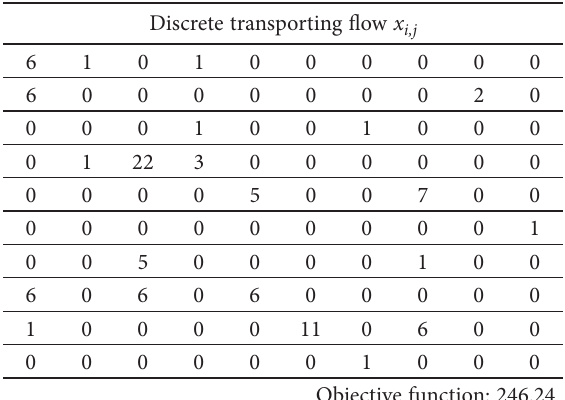
Table 15. Best obtained discrete solution for the 10×10 test problem with cost function